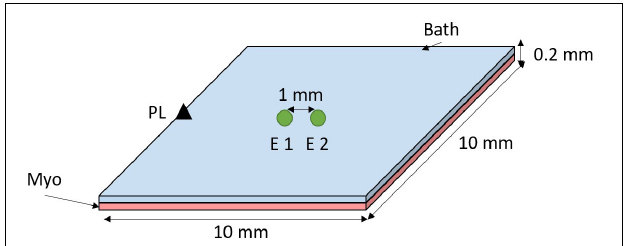
FIGURE 1 | Computational model setup. A sheet of myocardium (pink) is covered by a thin layer of bath (blue). The tissue was paced at the middle left edge (black triangle). Bipolar electrograms were measured at the center of the tissue by subtracting the signals from electrodes (E) 1 and 2–1 mm apart